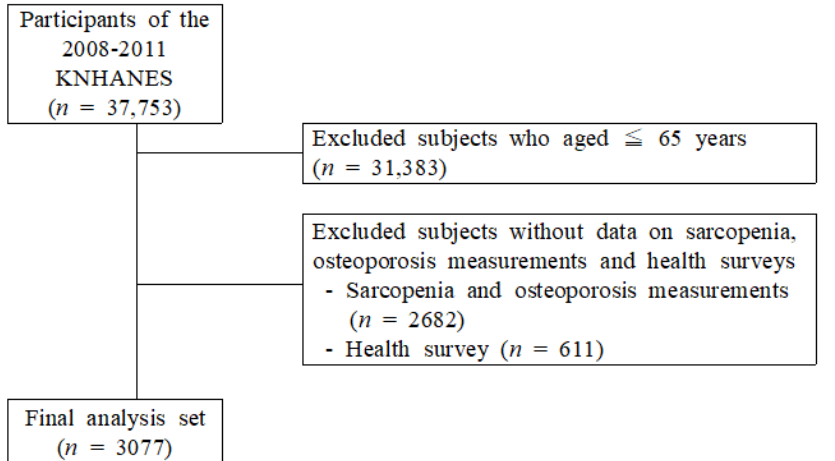
Figure 1. Selection of participants from the Korea National Health and Nutrition Examination Sur- vey 2008–2011.